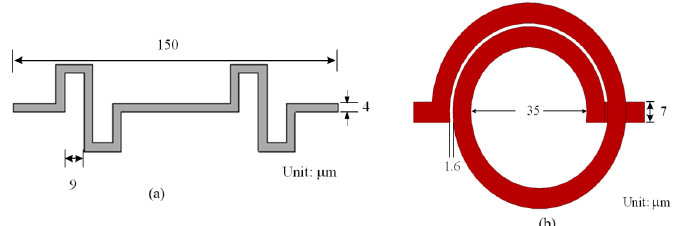
Figure 2. Dimensions of ( a ) spring; and ( b ) inductor.